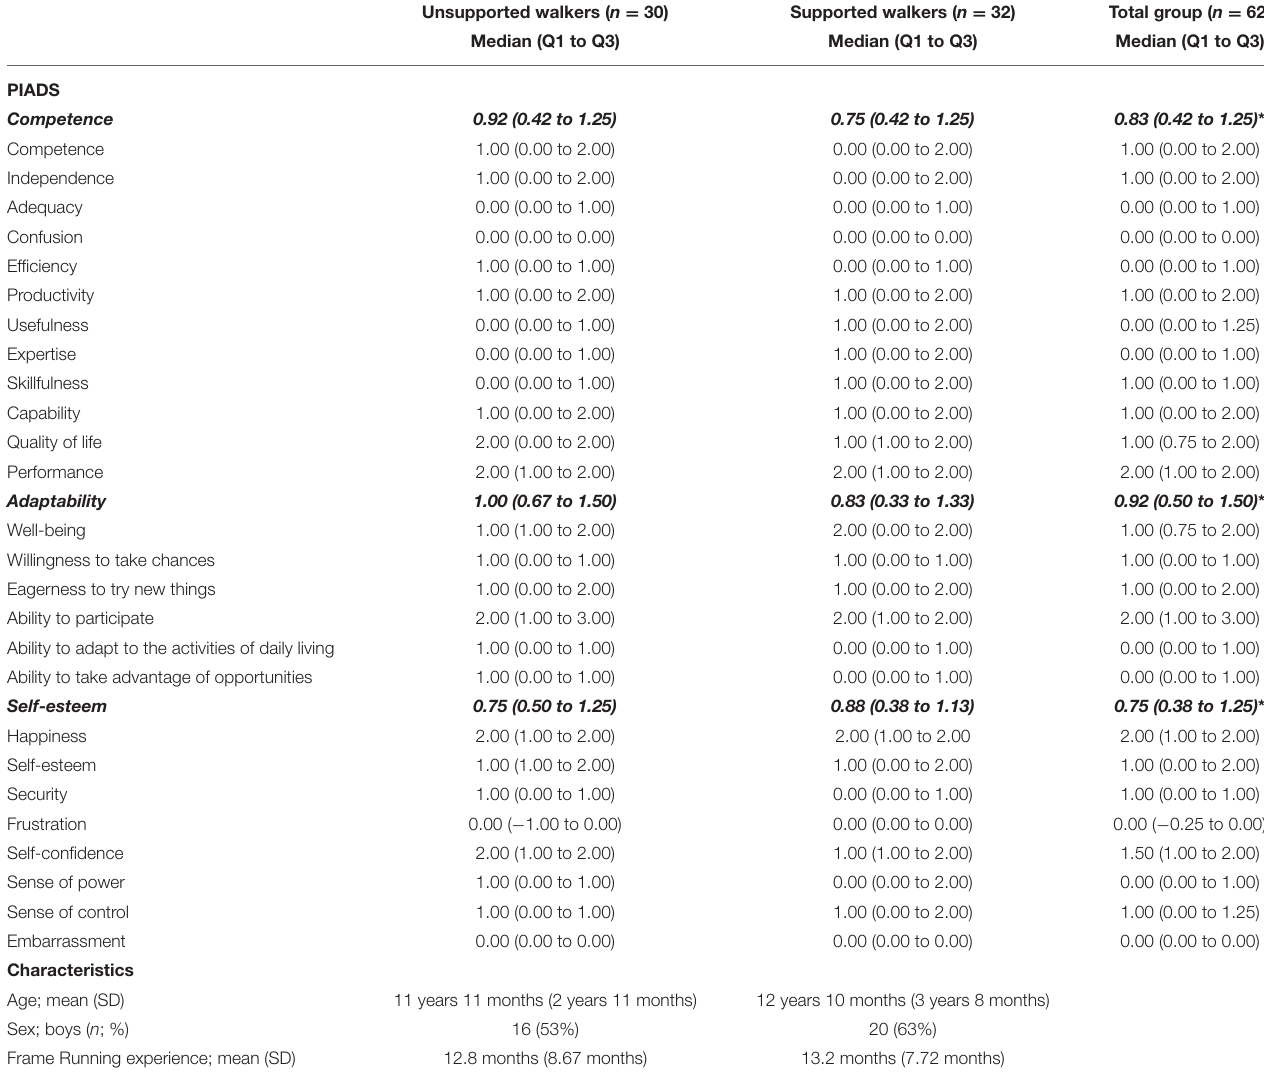
TABLE 2 | Results on PIADS domains and item scores of Frame Running